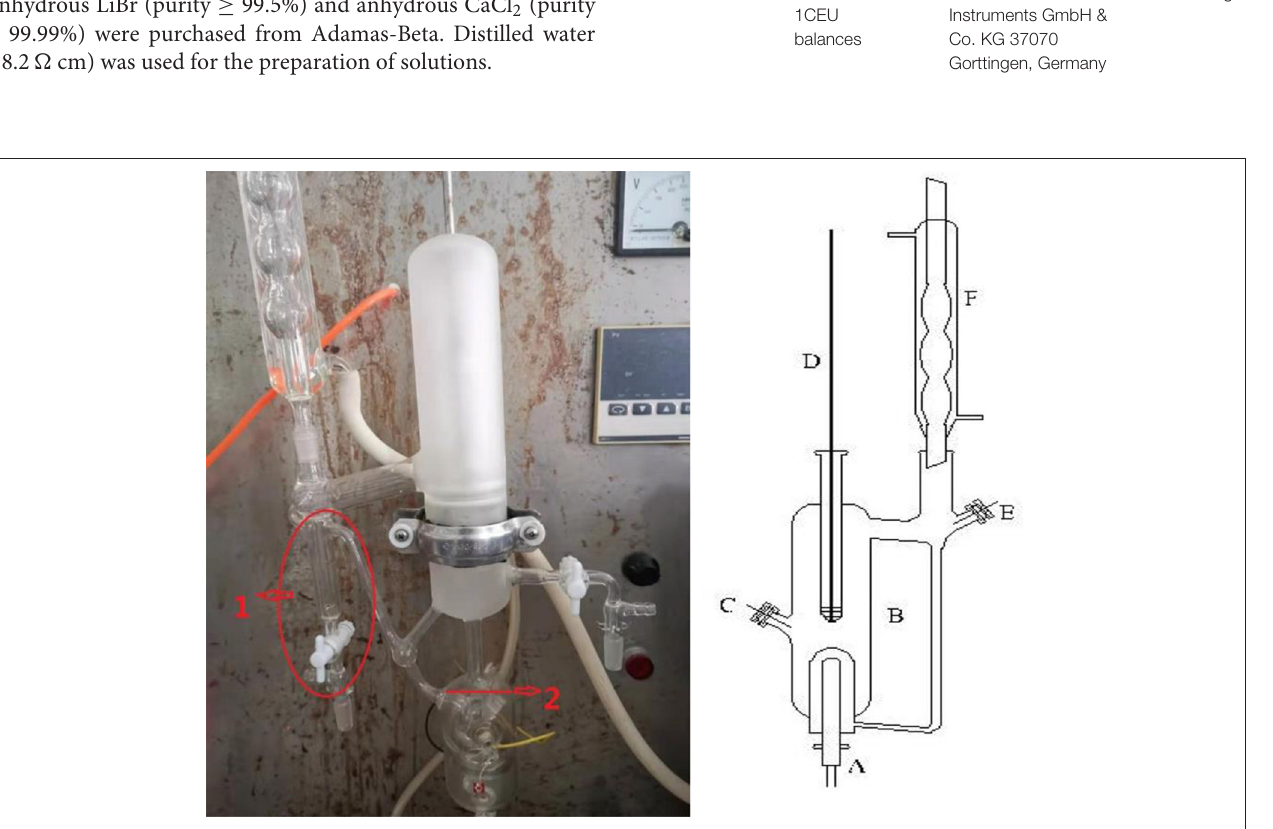
FIGURE 1 | A dual circulation glass